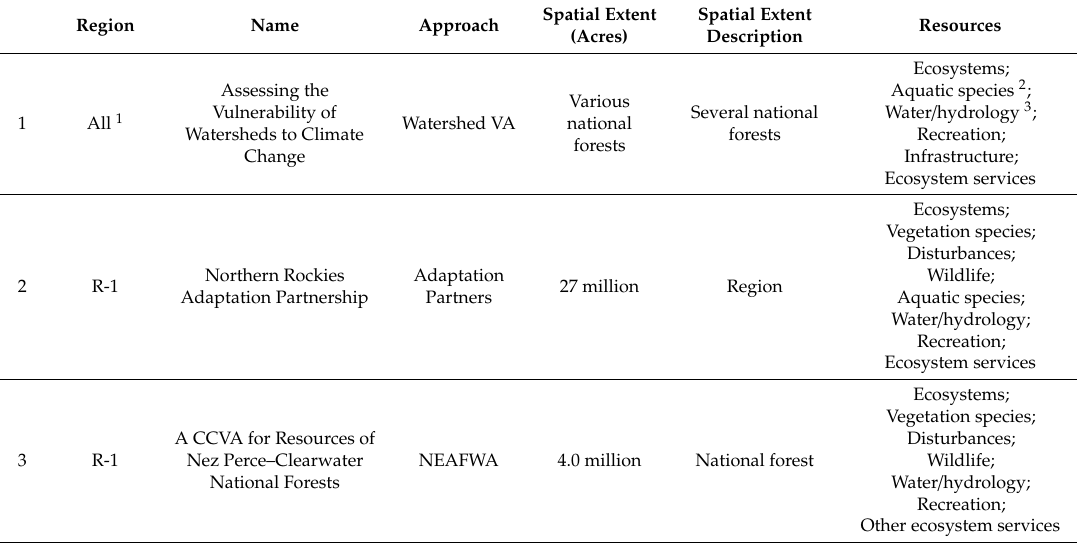
Table A1. Summary of vulnerability assessments included in this